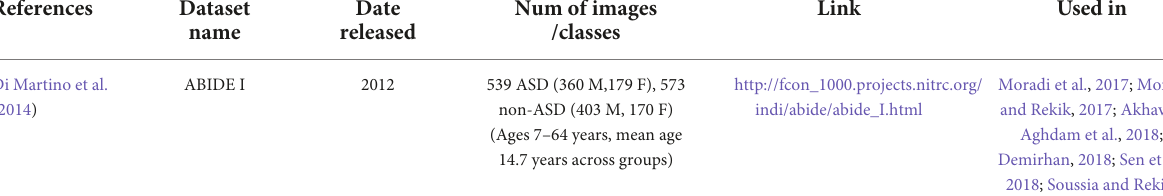
TABLE 5 Summary of publicly brain MRI datasets used in ASD studies.